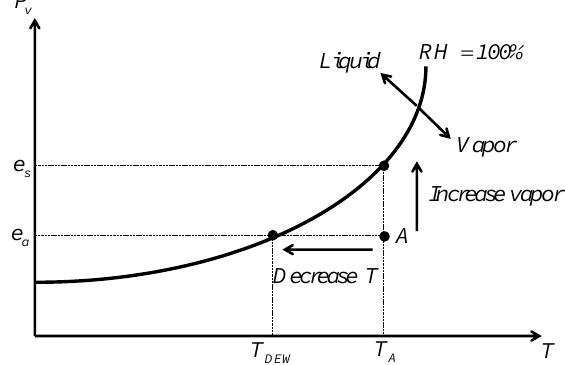
Figure 3. Graph of vapor pressure ( P v ) against temperature ( T ), showing the position of saturated vapor pressure ( e s ) and dewpoint temperature ( T DEW ). RH = relative humidity.